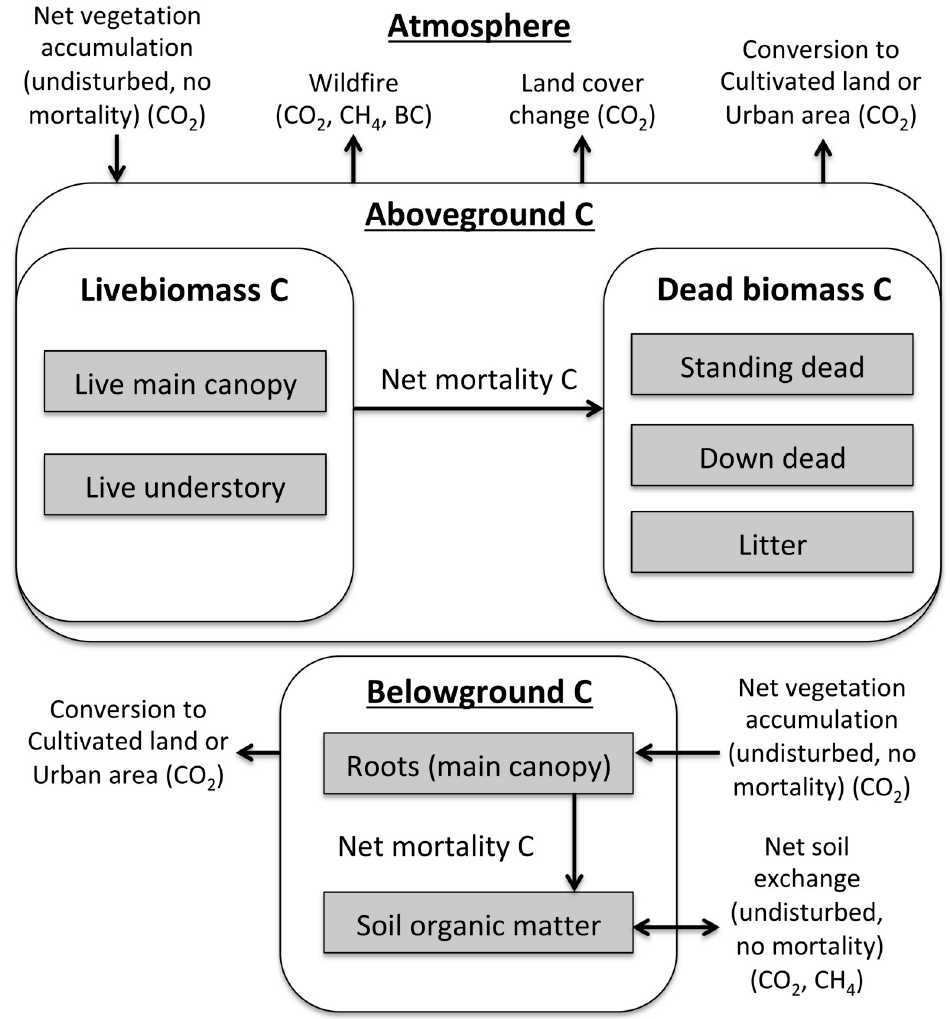
Fig 4. General CALAND carbon dynamics across all land types. Climate, wildfire, land cover change, and management can affect net vegetation and soil carbon fluxes and mortality rates. See Table 2 for each land type’s carbon